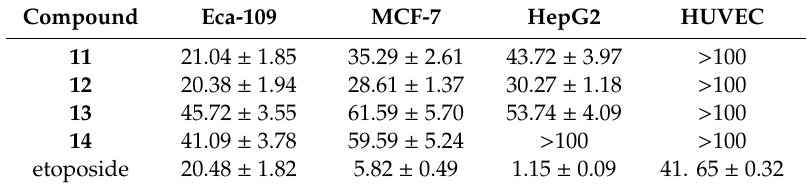
Table 3. Cytotoxicities of compounds 11 – 14 against Eca-109, MCF-7, and HepG2 cell lines (IC 50 , µ M).